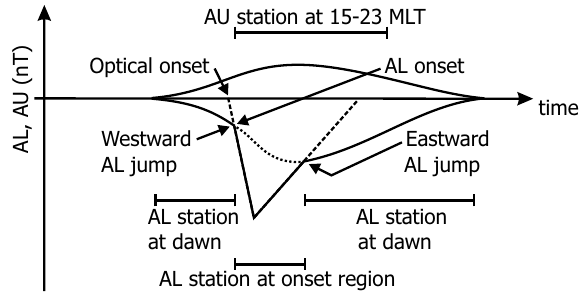
Fig. 9. Illustration showing the typical behavior of the auroral elec- trojet indices AL and AU (inspired by Fig. 13, p. 13041 in Kamide and Kokubun, 1996). The two components of the westward electro- jet (wedge and convection) are indicated. The AL station is located at the onset region during the wedge phase (expansion and early recovery